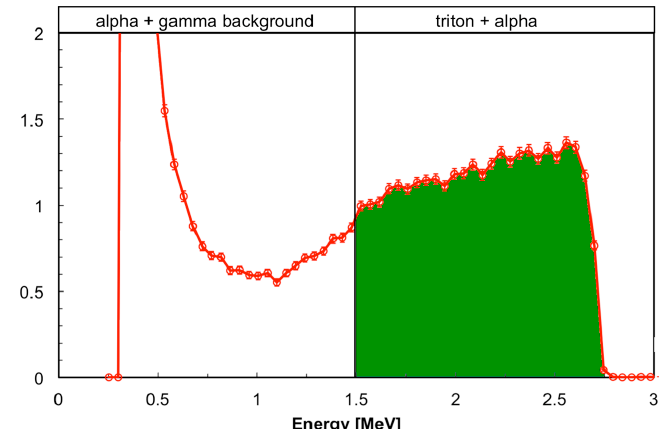
Figure 14. Deposited energy spectrum measured with one of the samples placed on a 3 × 3 cm 2 silicon detector exposed to a thermalized AmBe neutron source.